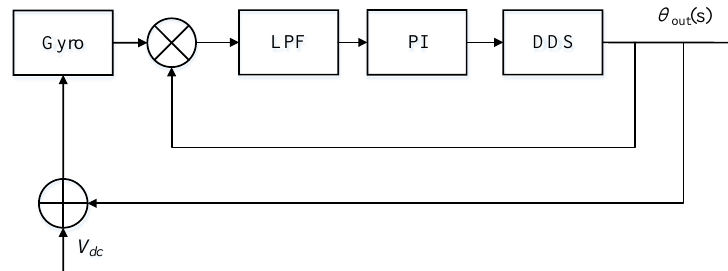
Figure 3. Principle of phase control loop.